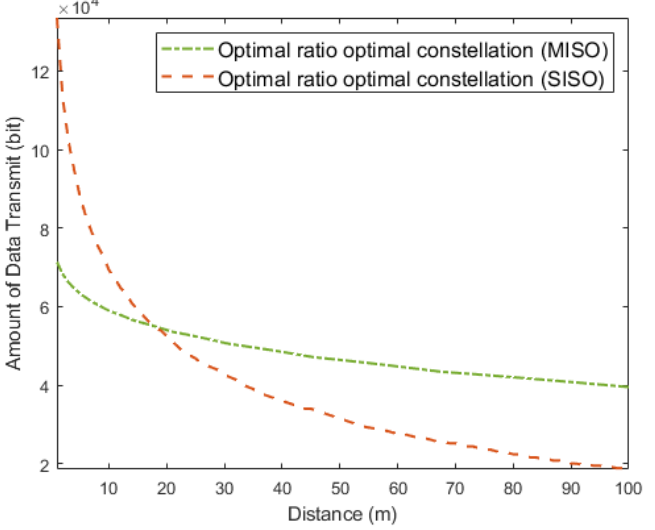
Figure 8. Comparison of MISO and SISO with the optimized constellation size optimized-time ratio.